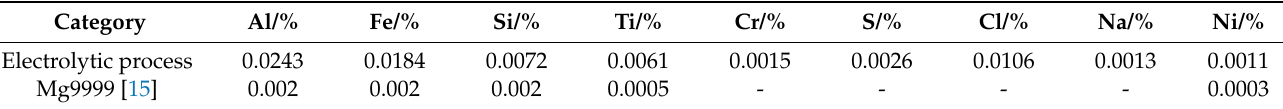
Table 1. Typical impurity content in the CM products determined via GD-MS.